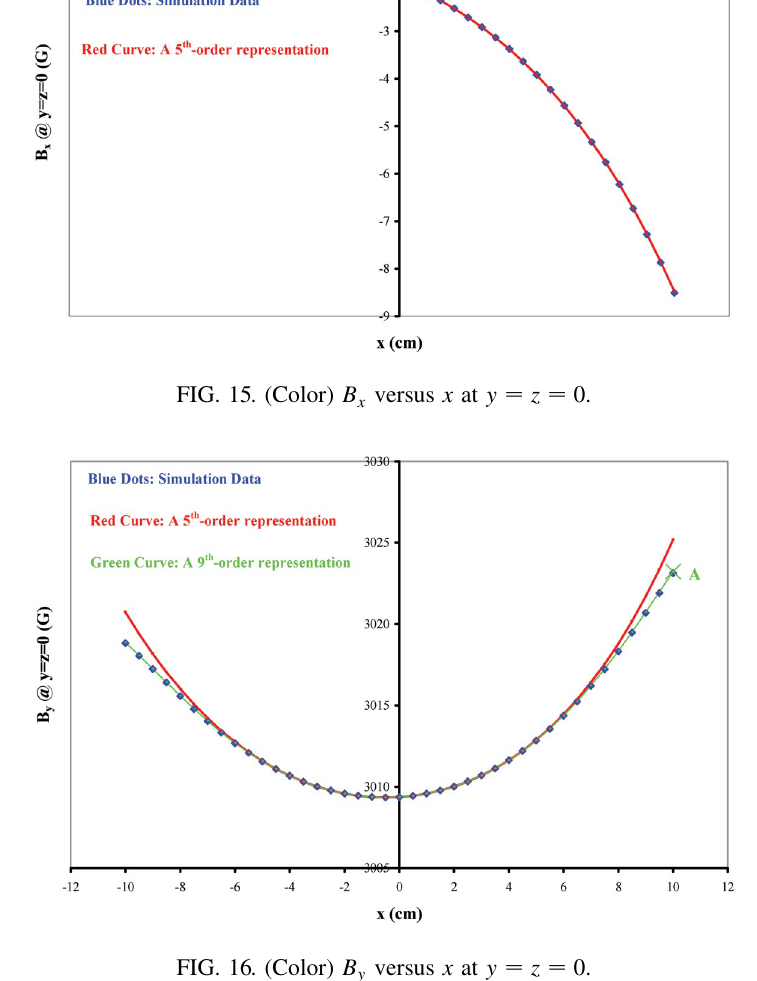
versus x at y (cid:2) z (cid:2) 0 . y